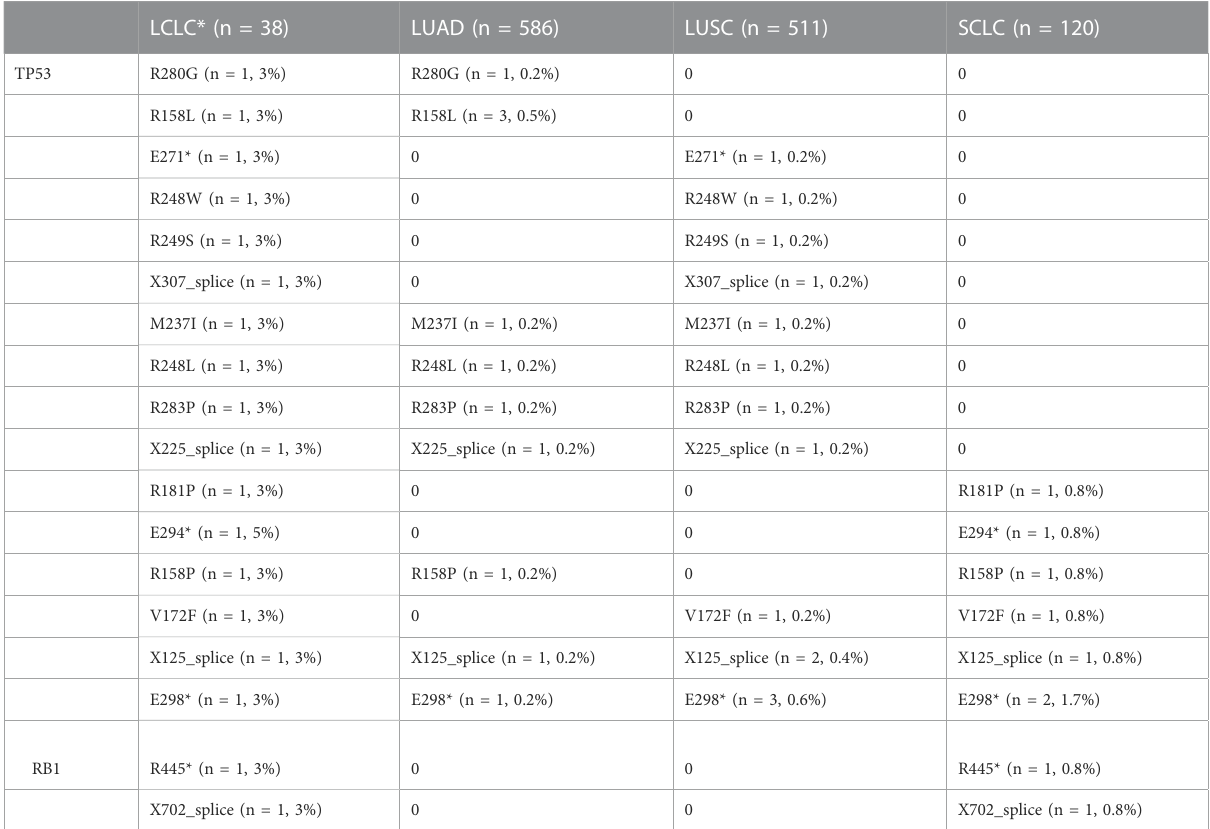
TABLE 3 Distribution of mutations in different subtypes of lung cancer.